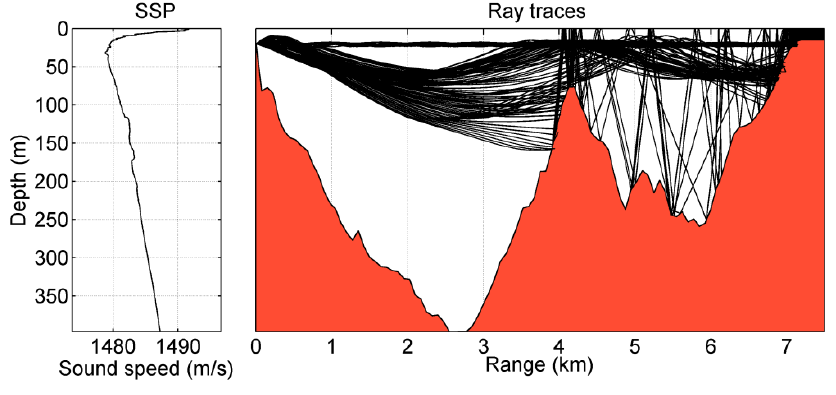
Figure 2. Measured SSP (the left panel) and the ray traces (the right panel) from a source on the left. The source was at a depth of 20